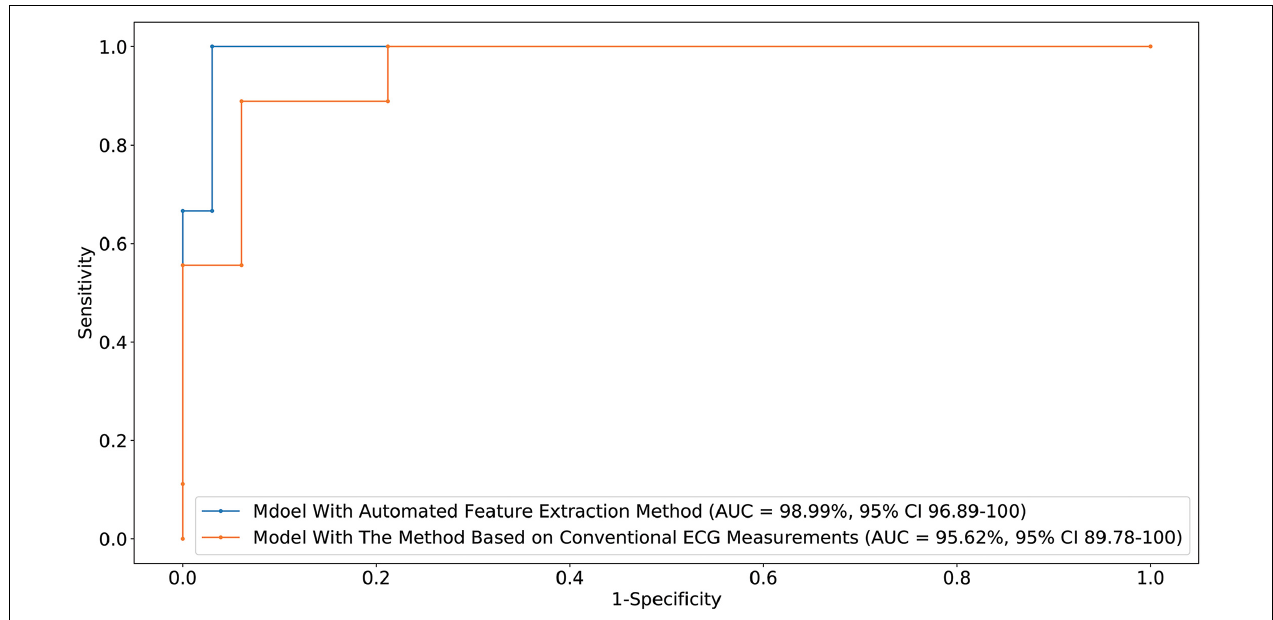
FIGURE 5 | Receiver-operating characteristic curve generated by the optimal machine learning model supplied with two feature extraction methods. The CI for the AUC was estimated using the Sun and Su optimization of the Delong method. Sensitivity and specificity of RVOT prediction are indicated for different